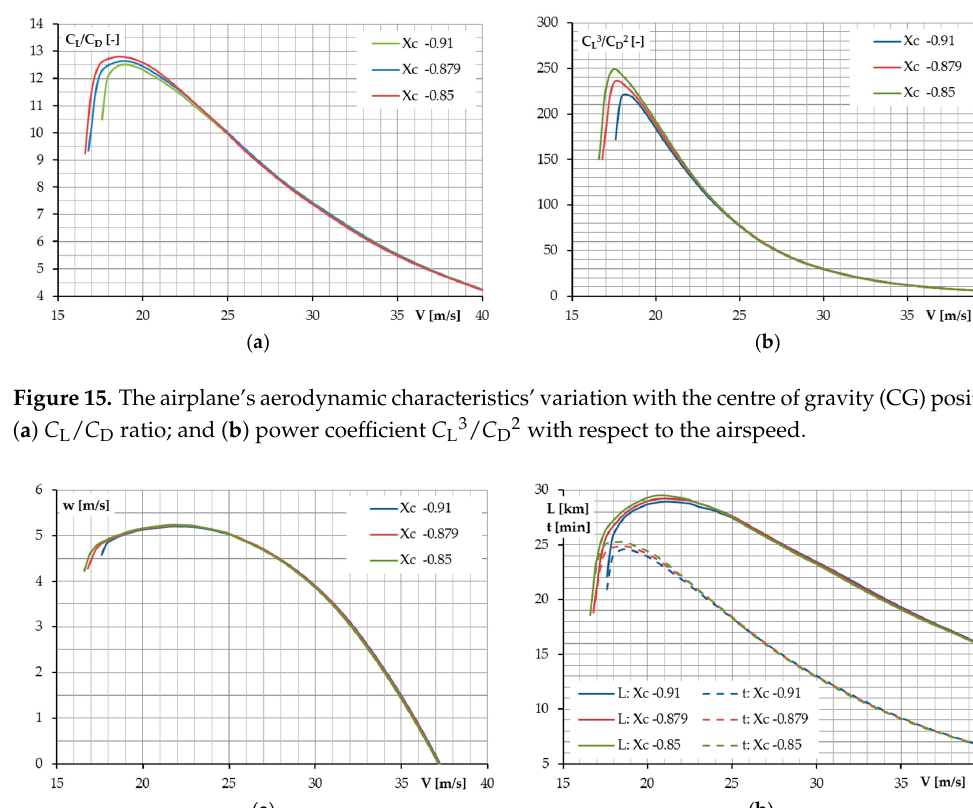
Figure 16. Variation in the airplane’s performance with the CG position: ( a ) maximum climb rate; and ( b ) range and flight duration with respect to the airspeed.